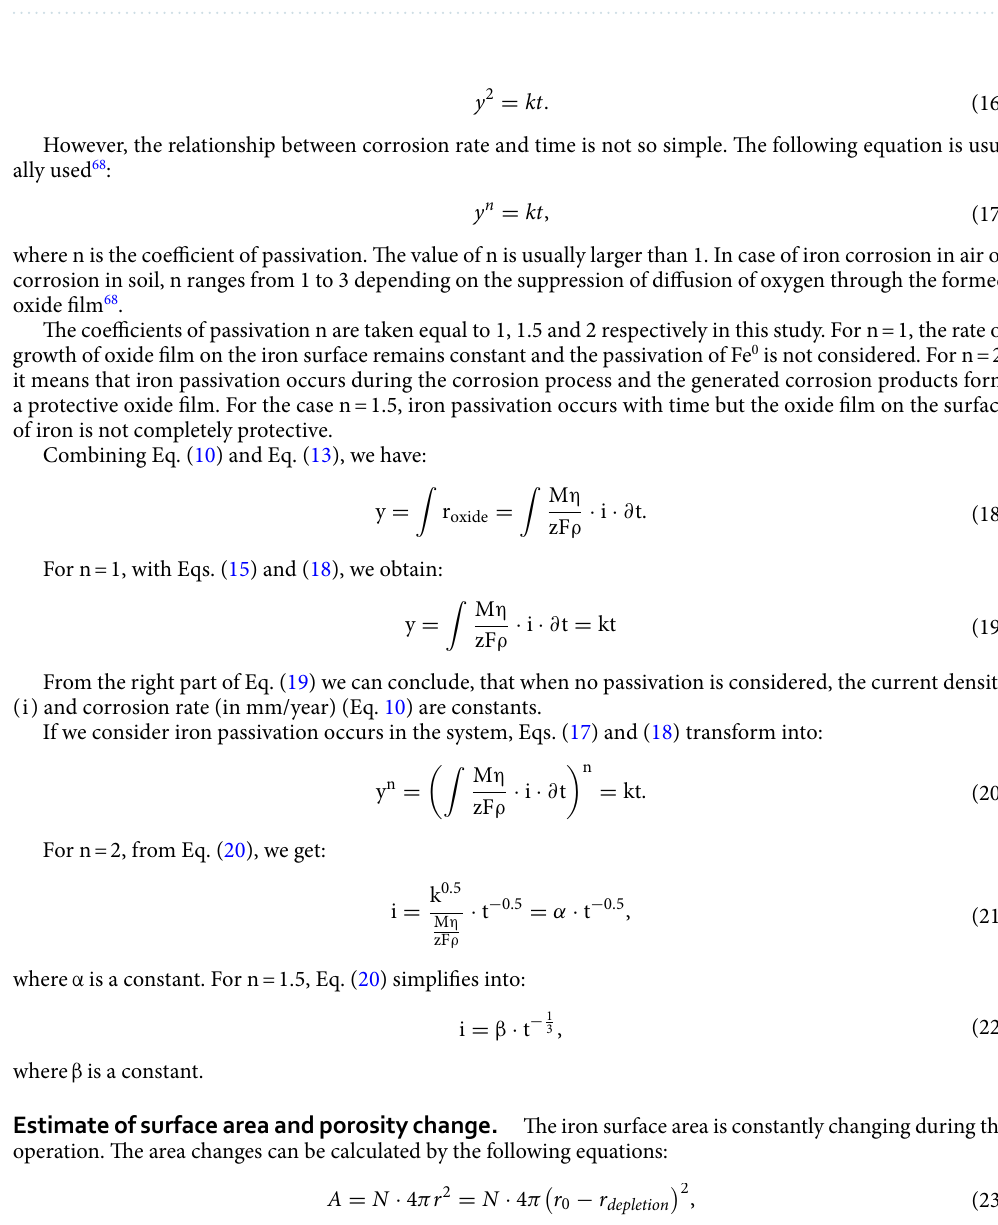
Table 1. Volumetric expansion coefficients of possible corrosion